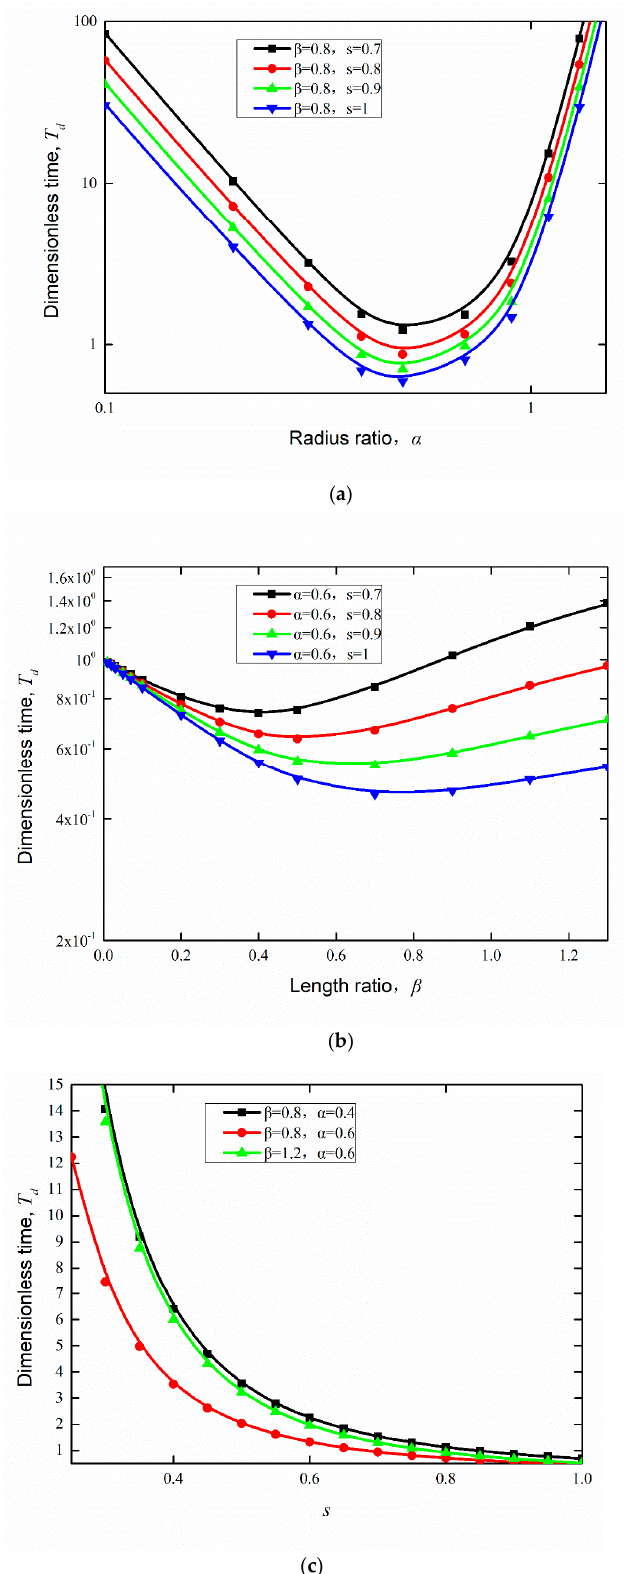
Figure 5. Dimensionless time curves of capillary flow at n = 4. ( a ) The curve of change with radius ratio α at different s values, ( b ) curve of change with length ratio β at different s values, ( c ) curve of change with radius s values at different radius ratios α and length ratios β . When the total number of branching levels n is 3 to 4, the minimum dimensionless T and the corresponding α , β , and s are all changed, where =0.4518 T , s = 1, time d d α = 0.5567, and β = 0.6896. Under the same conditions of length, volume, and specific T of the four-stage branching model is 54.82% surface, the spontaneous imbibition time d lower than that of the capillary bundle model. According to the above curve, a conclusion can be drawn: under the condition that s = 1 (with same wetting strength), the shortest time d T can be obtained, and the fluid imbibition speed in the multi-stage branching model will be faster. In order to make a comparison between a capillary bundle model, which is restricted by the same length, porosity, and permeability as the tree-like network model ( s = 1), the dimensionless imbibition time was calculated for different dimensionless distances l d . The dimensionless distance l d is the total length of the Y-shaped branching model divided by the length of the first branch, which is normalized to avoid the value of the model length and to facilitate the comparison under different conditions. The relationship between di- mensionless time T d and dimensionless length l d is shown in Figure 6. The result confirms that the imbibition process in the capillary bundle model obeys the rule described by the Washburn equation. However, the imbibition in the tree-like network model did not obey the Washburn equation. With the same l d , a shorter imbibition time was observed in the tree-like network model. The minimum dimensionless time T d = 0.5154 was calculated precisely under the conditions of s = 1, α = 0.5143, and β = 0.6557. Hence, the imbibition process can be accelerated in the tree-like network models.